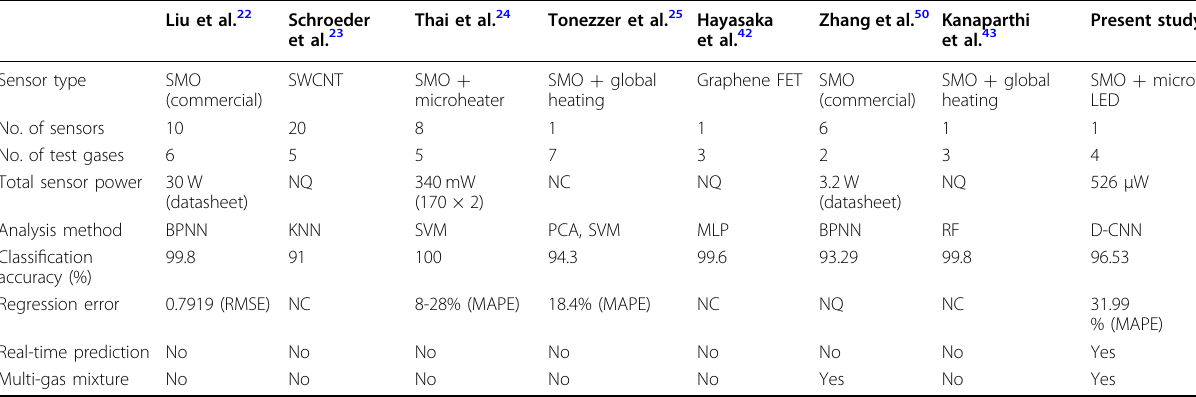
Table 1 Summary of machine-learning-based electronic nose technology-related studies in the last three years Liu et al. 22 Schroeder et al.